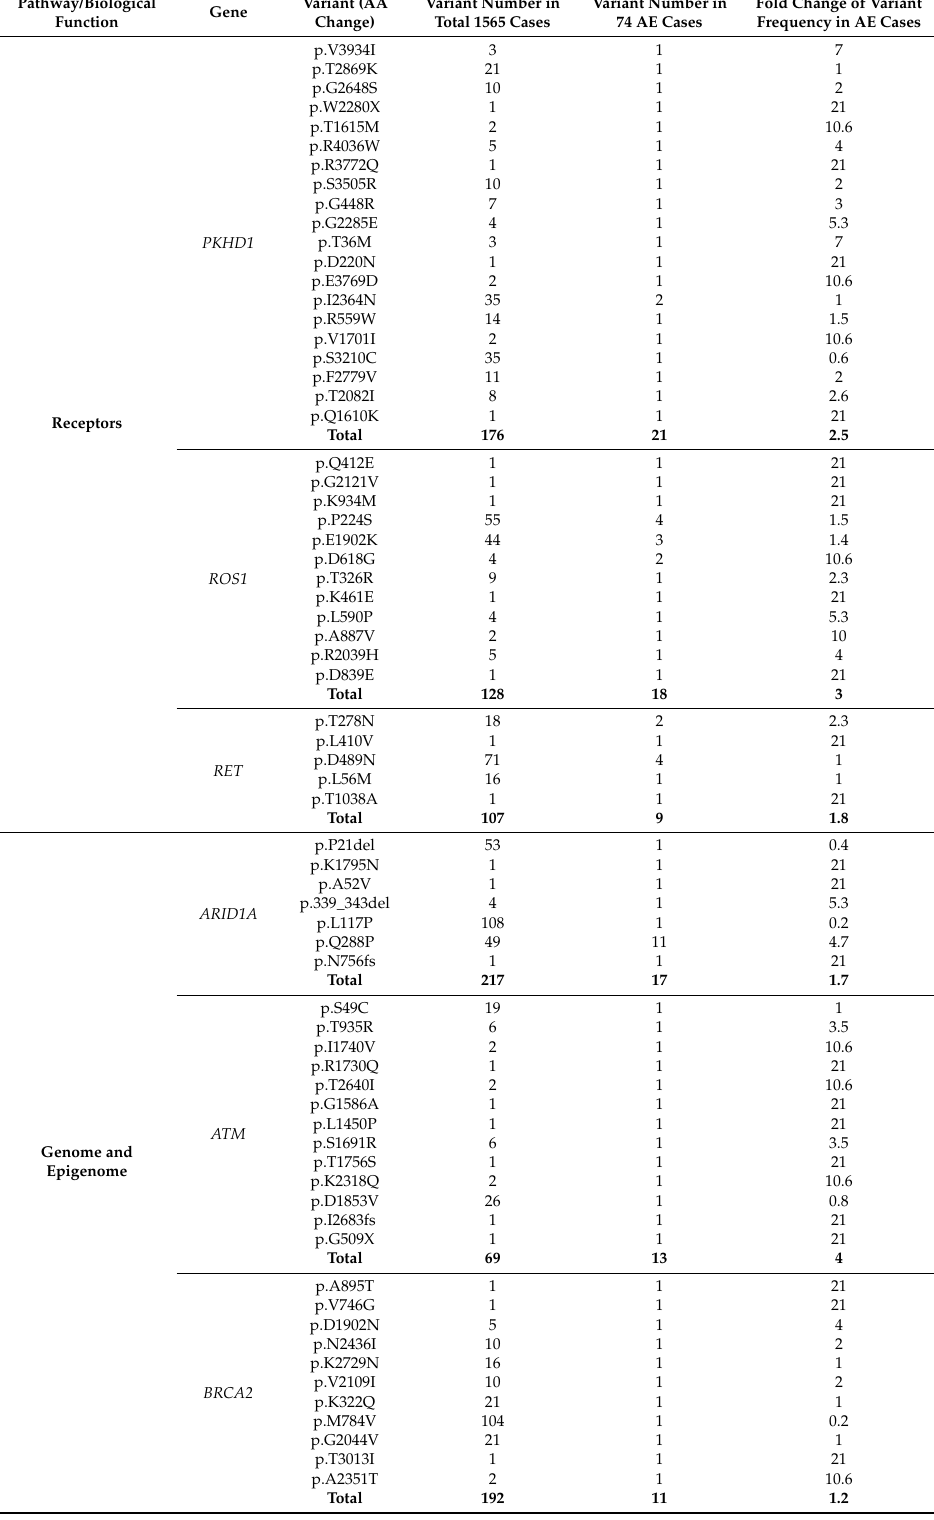
Table 4. Mutation Numbers and Types of Top Three Mutated Genes and Their Enrichment in AE cases. Pathway/Biological